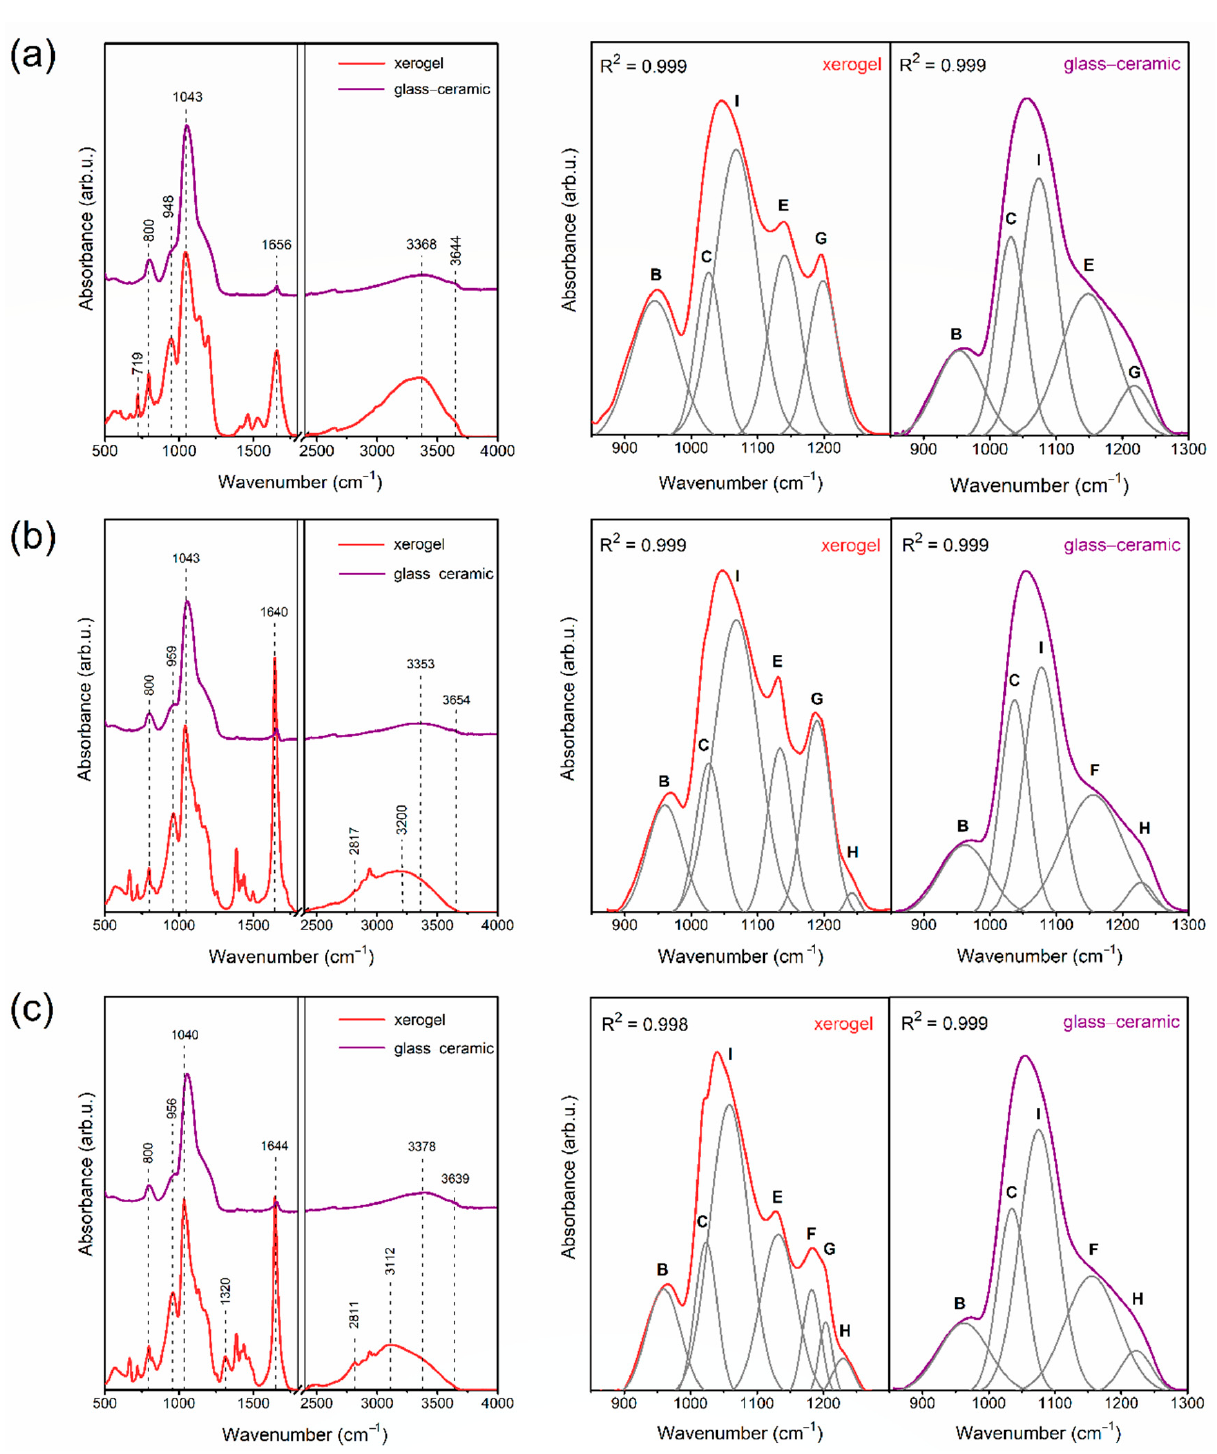
Figure 5. The comparison of IR spectra recorded for SG1 ( a ), SG2 ( b ) and SG3 ( c ) samples before and after controlled heat treatment. Deconvolution within the 850 cm − 1 –1300 cm − 1 frequency region is also shown. From the deconvolution of spectra within the 850 cm − 1 –1300 cm − 1 frequency region, the intensities of the B (958 cm − 1 , Q 2 units) and C deconvoluted components (1043 cm − 1 , Q 3 units) decreased due to their conversion into Q 4 units (band E, 1144 cm − 1 )